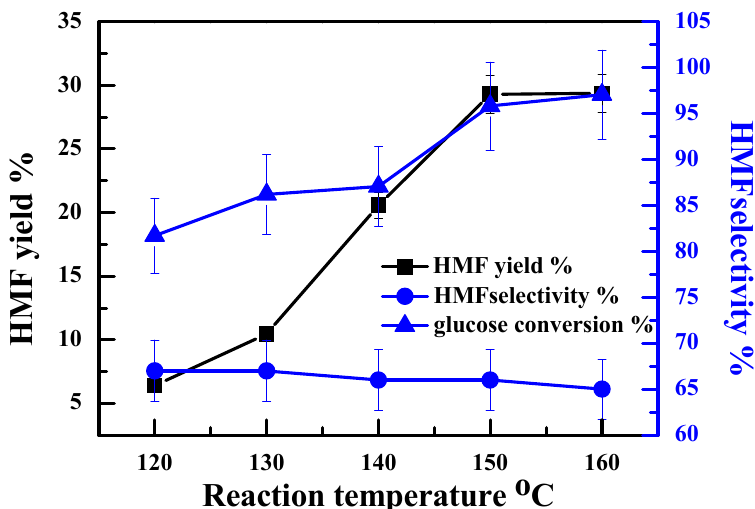
Figure 4. Effect of the reaction temperature on HMF yield, during glucose conversion.Experimental conditions: 0.15 g ZrOCl 2 , 0.05 g [HO 2 CMMIm]Cl, 0.1 g glucose, 3.0 g isopropanol, 3 h reaction time.